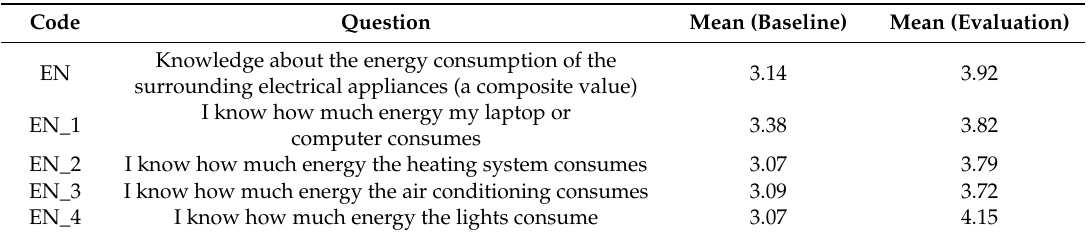
Table 10. Mean scores for factors related to knowledge on energy consumption (EN) (fully disagree (1) to fully agree